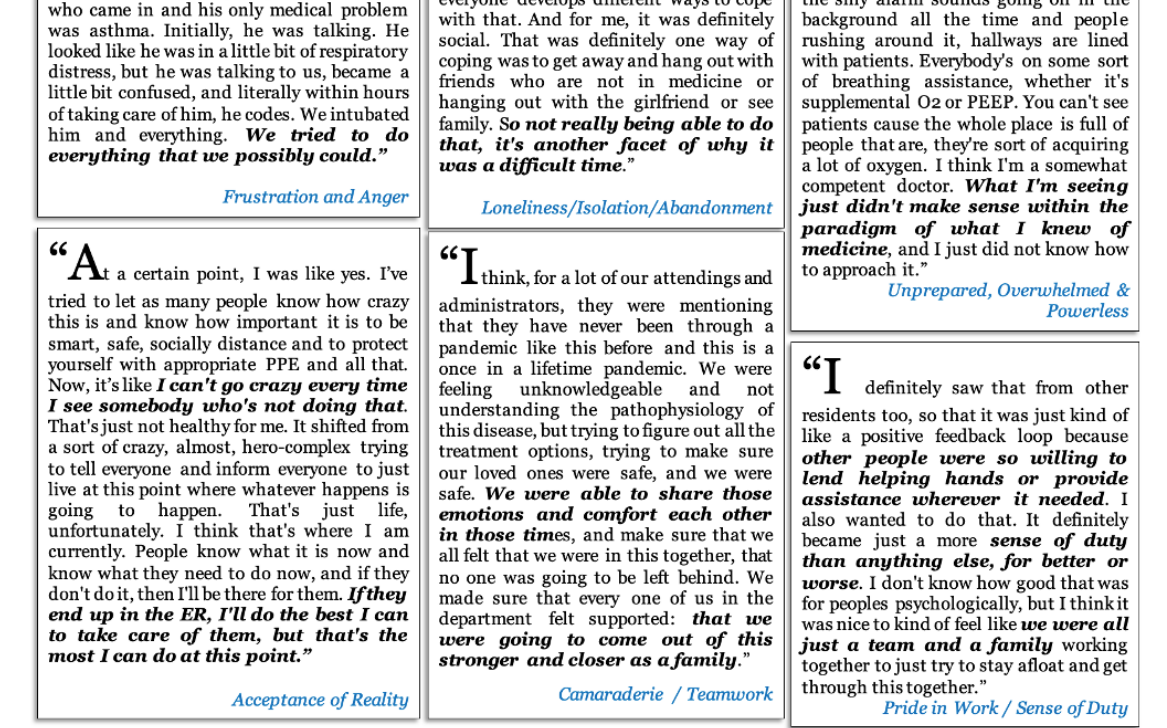
Figure 2. Quotations describing the emotional challenges and protective thoughts of 25 emergency medicine resident physicians regarding working and training during the first wave of the COVID-19 pandemic in two urban US hospitals, 2020. COVID-19, coronavirus disease; US, United